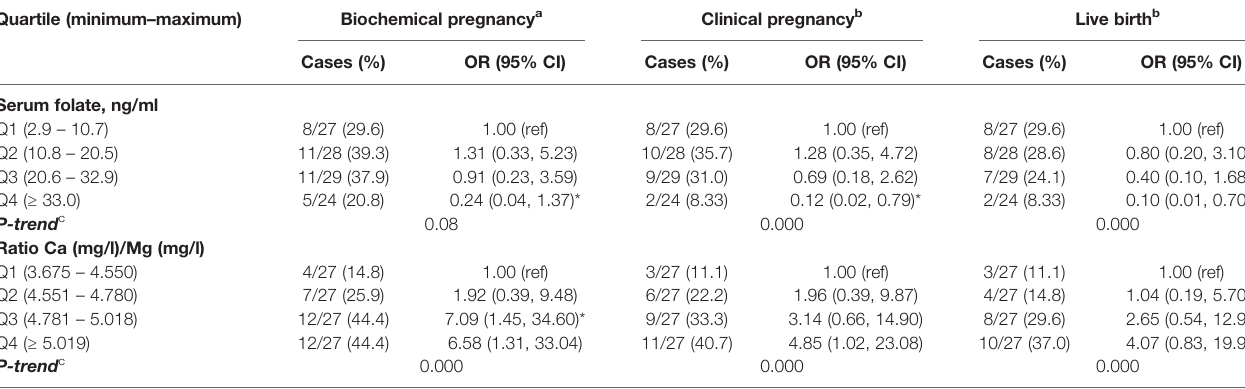
TABLE 4 | Associations of serum folate concentrations and clinical outcomes after assisted reproduction in 108 women. Quartile (minimum –